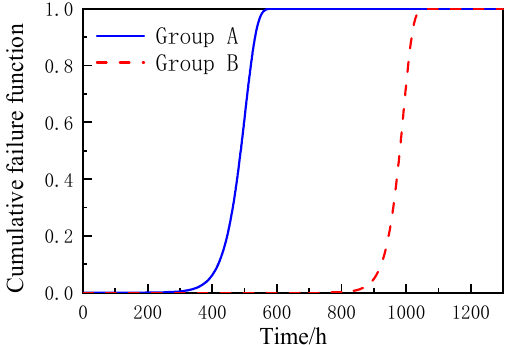
Figure 6. The cumulative failure function diagram of MOCRC.